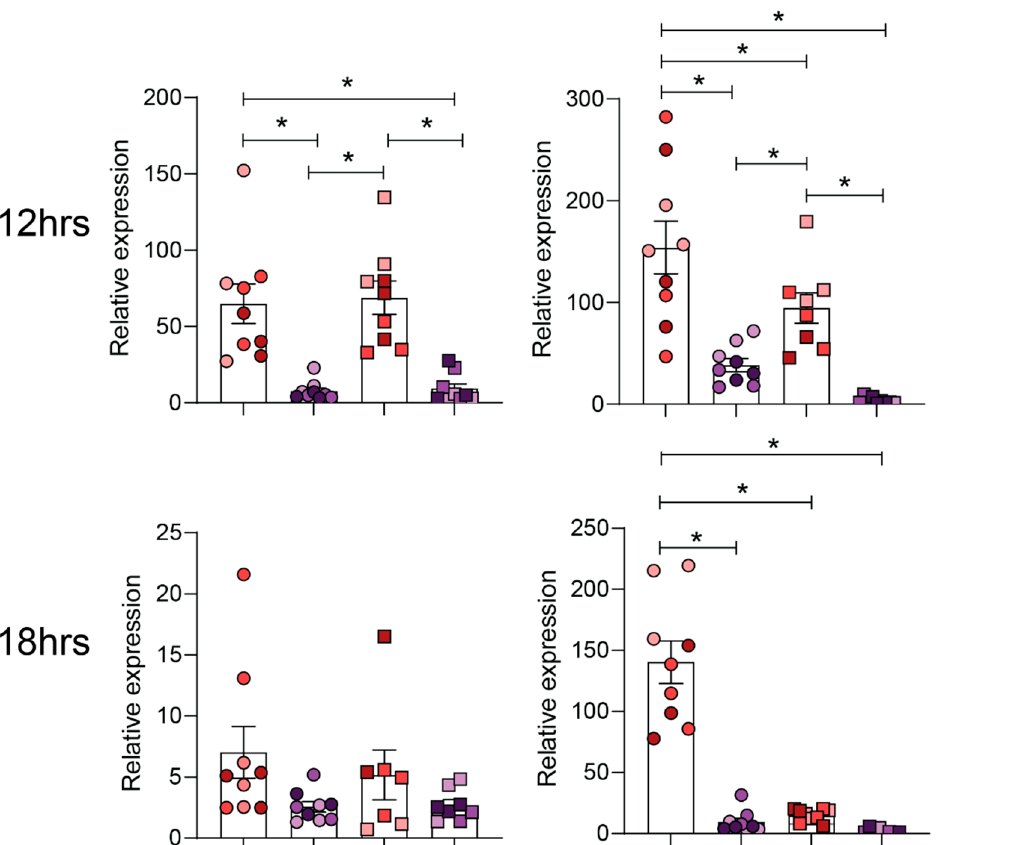
Figure 3. Cytokine response to polyI:C treatment in chicken and duck endothelial cells and fibroblasts. Avian endothelial and fibroblast cells were treated with either PBS or PBS containing 25 µg/mL PolyI:C (Sigma Aldrich). IL-6 and IL-8 gene expression were used as representatives for pro-inflammatory cytokine production and were analysed using the RT-qPCR analysis at different timepoints. Data are pooled ( n = 9) from three independent experiments with experimental replicates shown in the same colour. Statistical significance is represented by asterisks (* = p < 0.05) Results are means ± SEM.